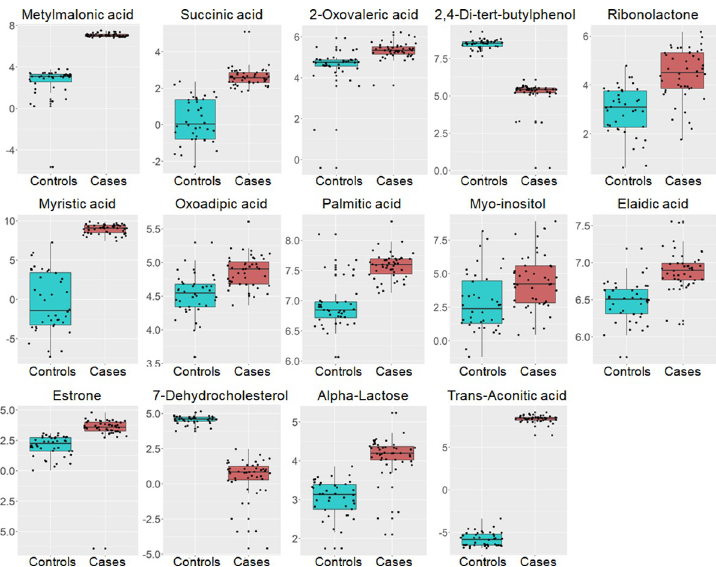
Fig 5. Regulatory pattern of urine metabolites associated with AVS in patients and control individuals. Data from urine candidate metabolites in the 46 AVS cases (orange boxes) and 46 controls (blue boxes) are shown. Data are normalized to the internal standard (2-isopropylmalic acid) and log transformed. The boxplots show the median and the inter-quartile range for each metabolite in the two groups.